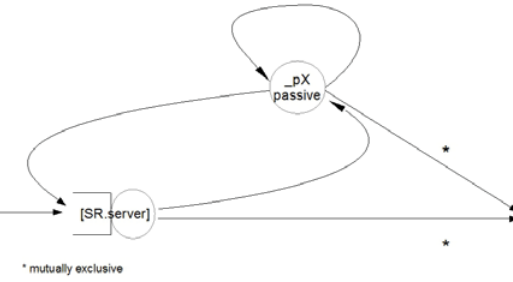
Figure 4: SRP transformation